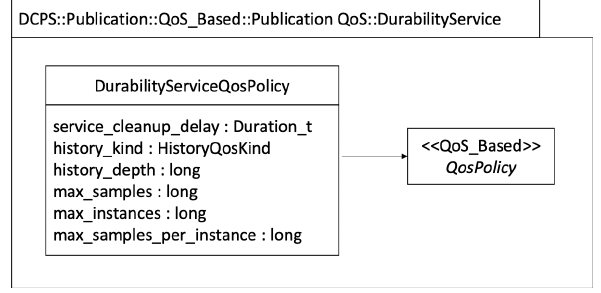
Figure 10. DurabilityService